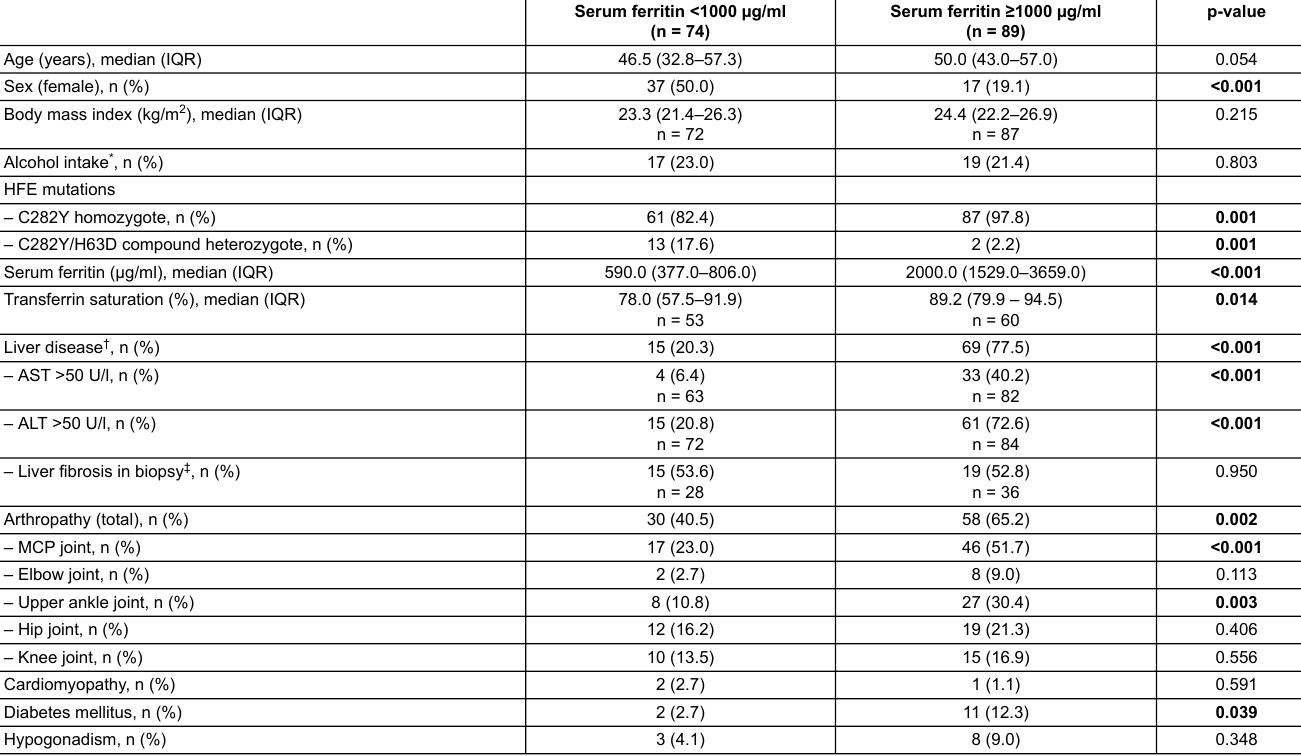
Table 2: Baseline characteristics, symptoms and laboratory measurements of patients with hereditary haemochromatosis included in the present analysis stratified according to substantial iron overload.